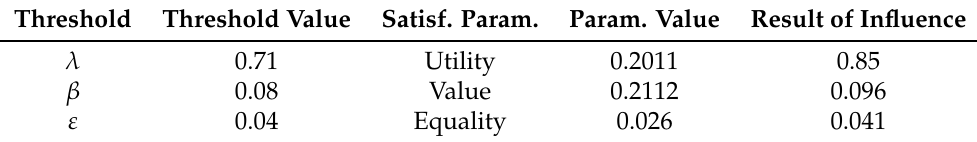
Table 16. Result of preference thresholds influenced by satisfaction.